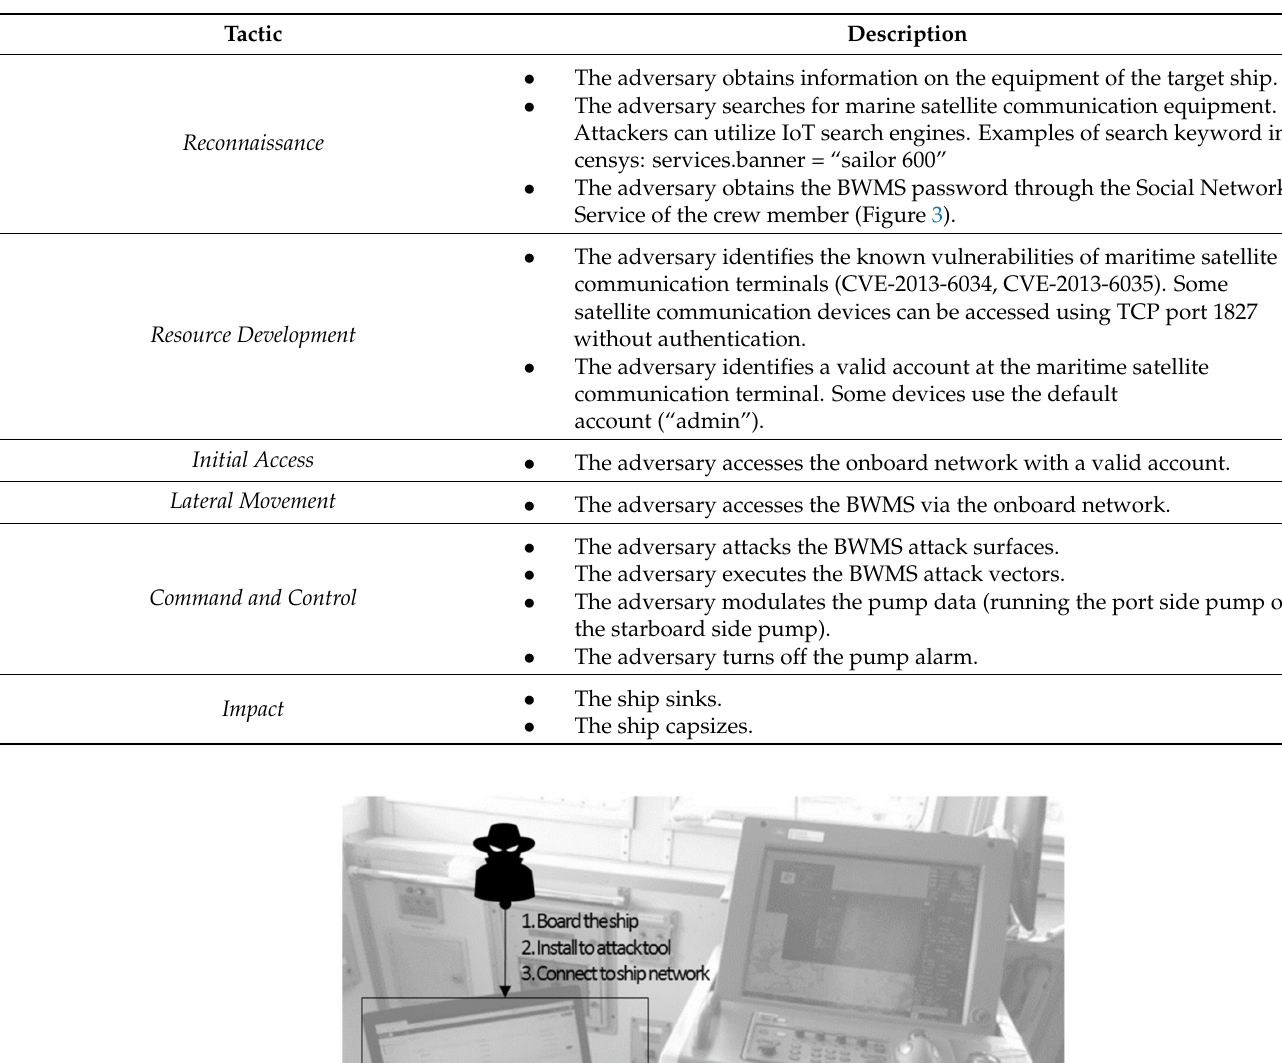
Table 3. MITRE ATT&CK analysis results for attack case 1.